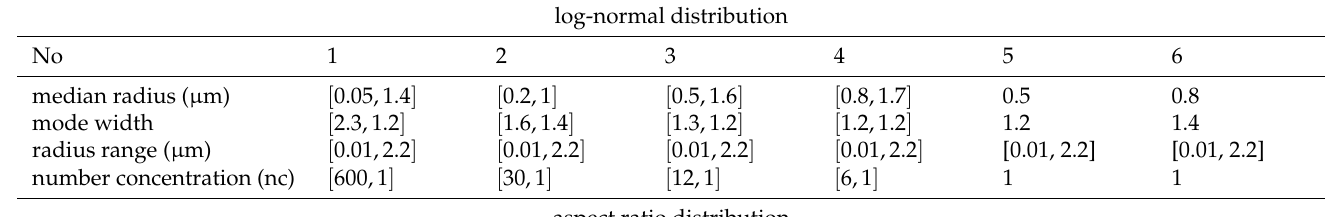
Table 3. Simulation setup for the reconstruction of bimodal shape-size distributions (BMD) with a fixed refractive index and 1% error level. The following combinations were used: BMD 1: (1, a, iii),